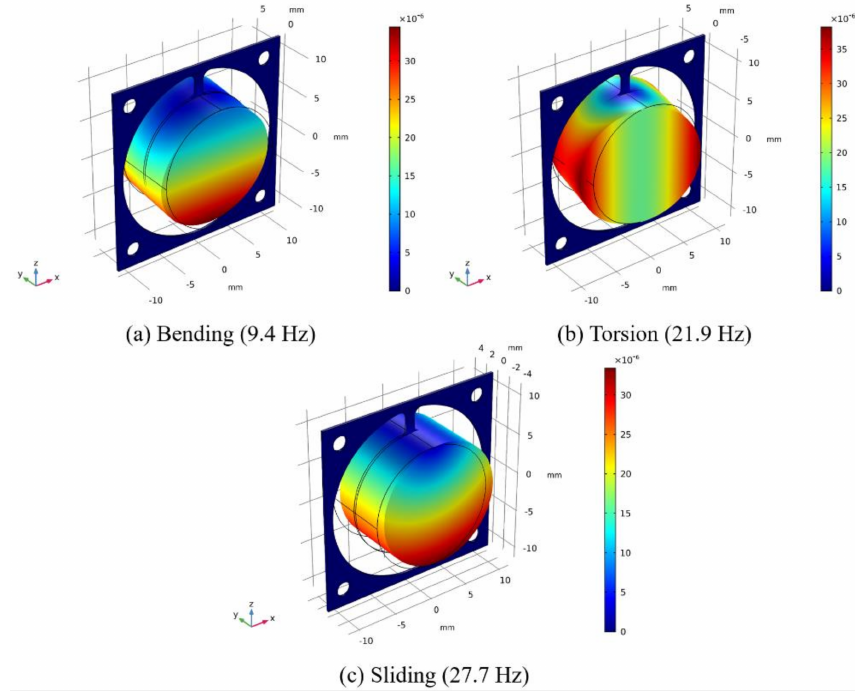
Figure 3. FEM modal analysis of the proposed